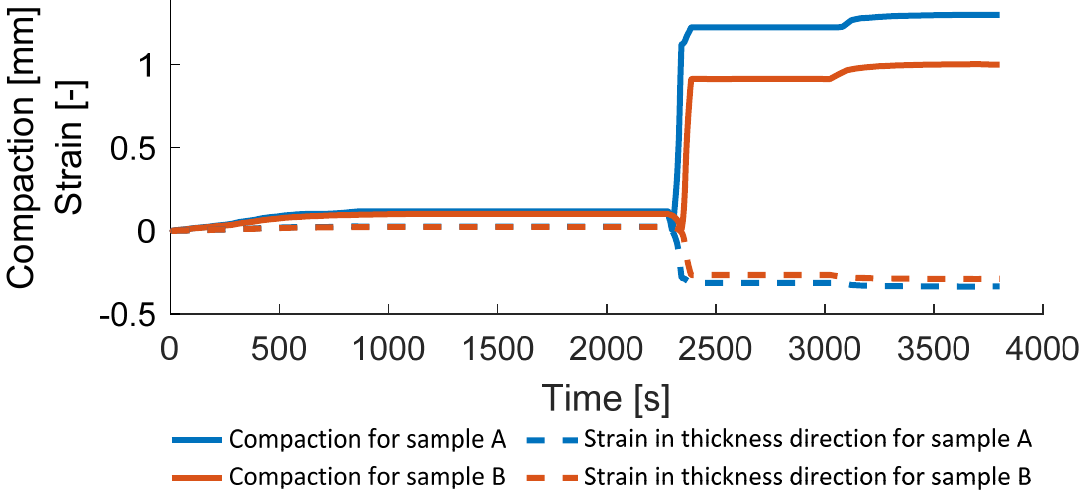
Figure 21. Compaction and strain of samples A and B.